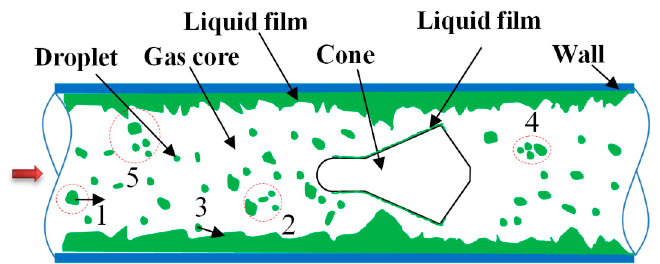
Figure 4. Interaction between gas and liquid when annular flow through pipe with inserted cone.